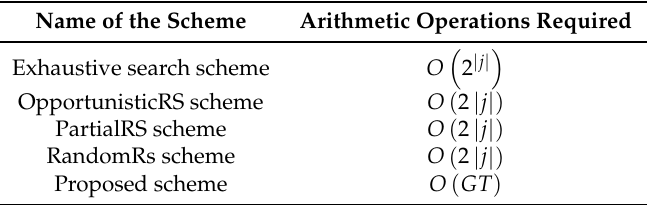
Table 3. Comparison of the complexity of various